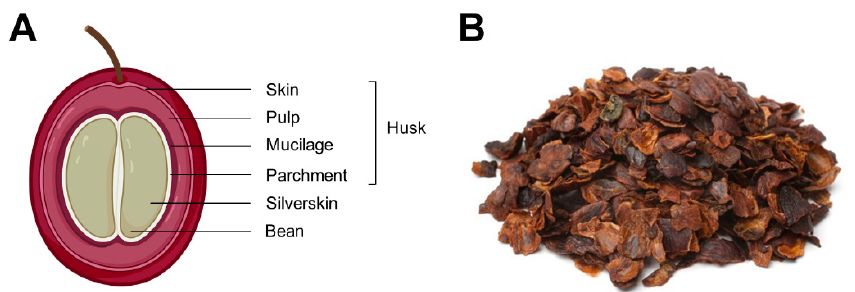
Figure 1. Coffee cherry anatomy ( A ) from the outside to the inside (skin, pulp, mucilage, parchment (comprising the coffee husk), silverskin, and coffee bean) and appearance of dried coffee husk once separated from the coffee bean ( B ).